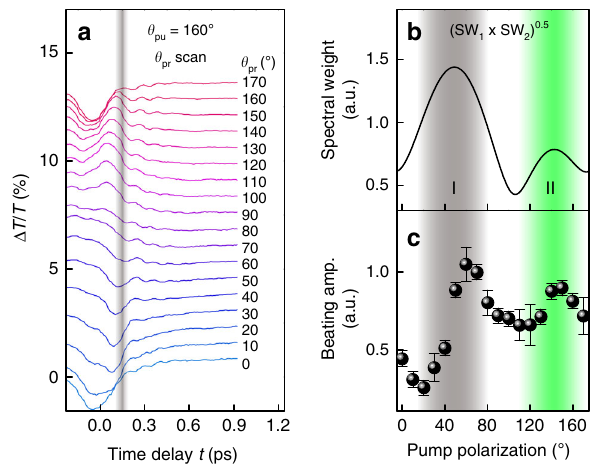
Fig. 5 Probe-polarization-dependent quantum beats. a θ pr -resolved DT with offset. θ pu is fi xed at 160°. Analyses are performed on the right side of the vertical gray line. b , c Comparison of beating amplitude obtained from theory ( b ) and experiments ( c ). Solid line in b is same as that in Fig. 4c. Gray (green) area represents the region I (II). The error bars represent 95% con fi dence intervals for the fi tting